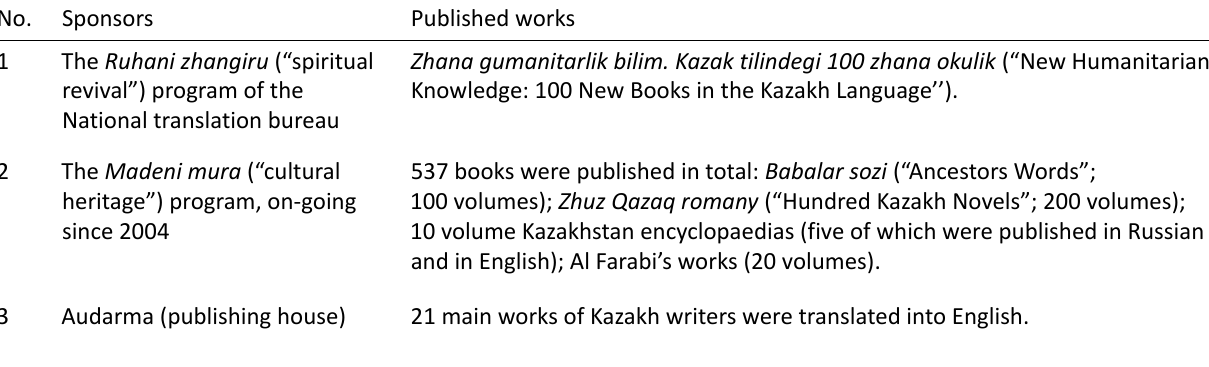
Table 1. Published works in the sphere of translation studies after the independence of the Republic of Kazakhstan, in 1991.